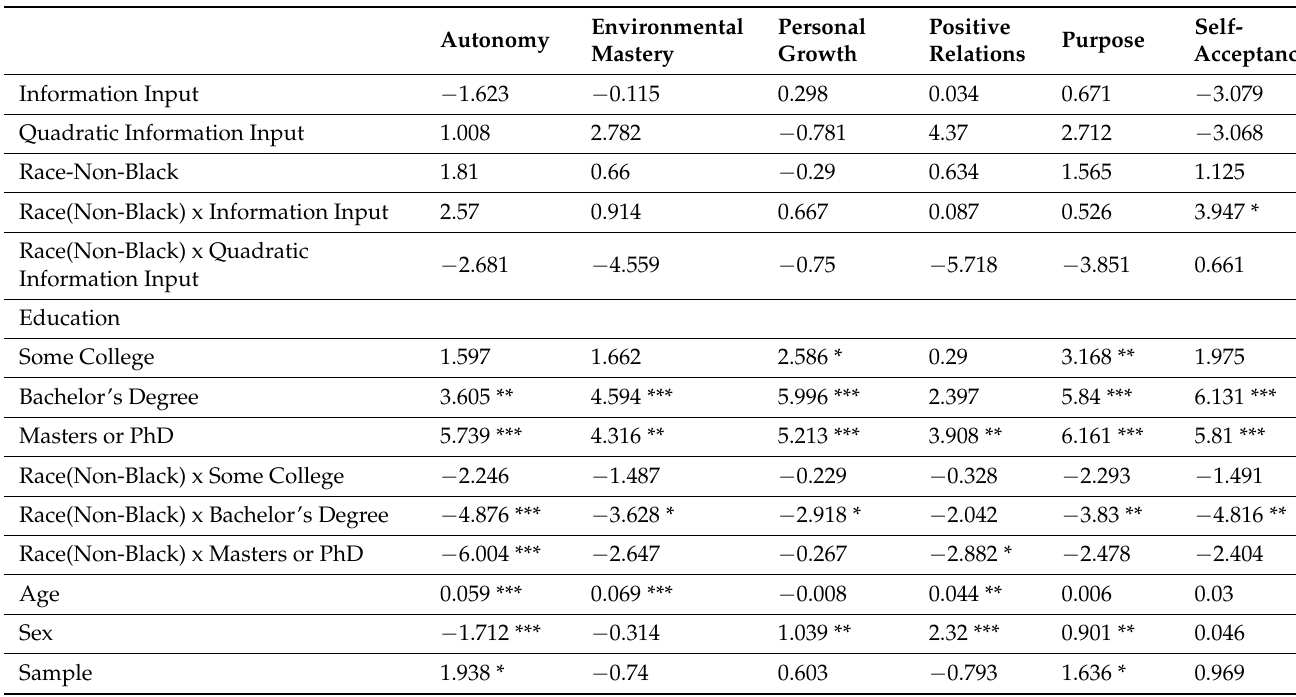
Table A2. Information Input and Well-being.